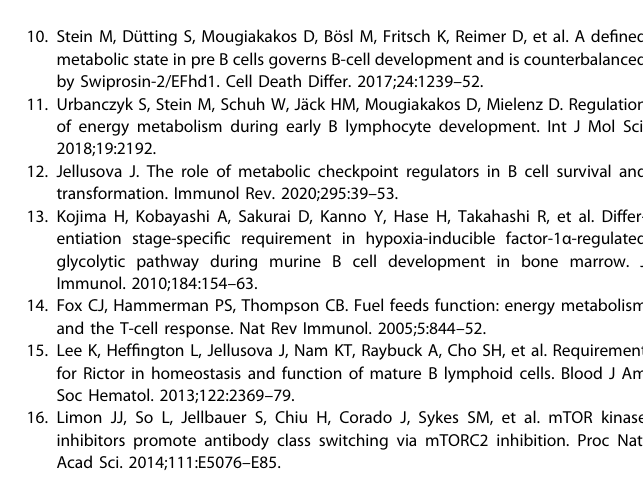
Fig. 7 miR-582 simultaneously targets mTORC2/AKT signaling to attenuate pre-B cell proliferation and survival. A Pre-B cells were infected with anti-miR-582 lentivirus and cultured for 72 h. The level of p-AKT, AKT, p-FoxO1, and FoxO1 was determined by Western blotting with β -actin as a reference control ( n = 4 – 5). B Pre-B cells were infected with anti-miR-582 lentivirus and cultured in the presence of the mTORC2 inhibitor JR-AB2-011 for 72 h. The level of p-AKT, AKT, p-FoxO1, and FoxO1 was determined by Western blotting with β -actin as a reference control ( n = 4). C Pre-B cells were infected with anti-miR-582 lentivirus and cultured in the presence of the mTORC2 inhibitor JR-AB2- 011 for 72 h. Cell proliferation and apoptosis were evaluated by CFSE labeling and Annexin V + and 7-AAD + , respectively, followed by fl ow cytometry, and quantitatively compared ( n = 3). D The signaling pathway of miR-582 regulate the proliferation and survival of pre-B cell. Bars represent means ± SEM, * P < 0.05, ** P <